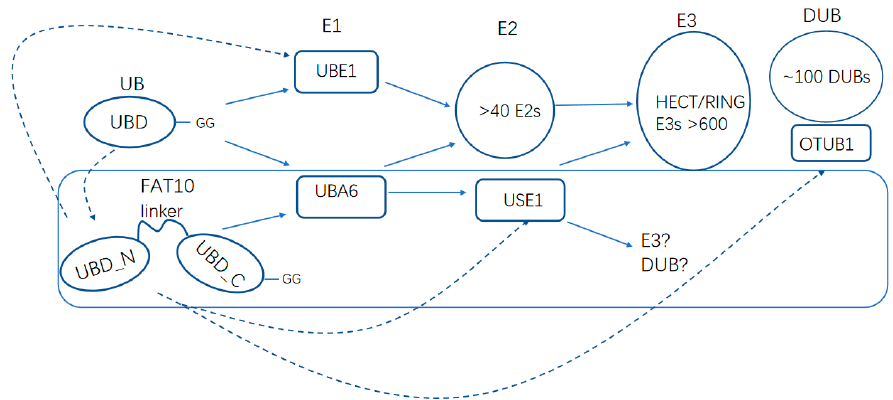
Figure 4. The enzyme cascades for FAT10 and ubiquitin. FAT10 and ubiquitin have mutual influence on the regulations. The dotted lines indicate the regulations of critical enzymes in the cascades by FAT10 and ubiquitin.